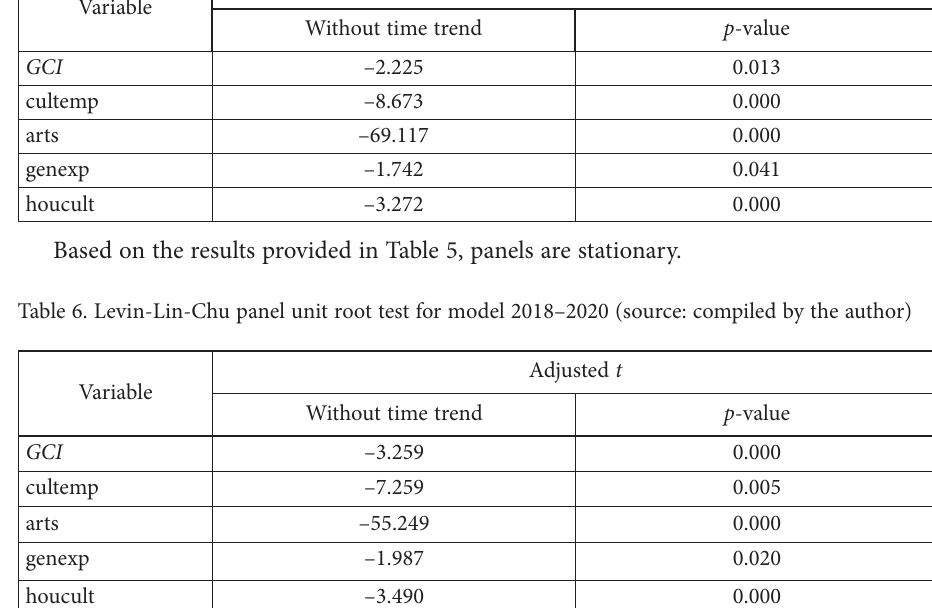
Table 5. Levin-Lin-Chu panel unit root test for model 2011–2017 (source: compiled by the author) Adjusted t Variable Without time trend p -value GCI